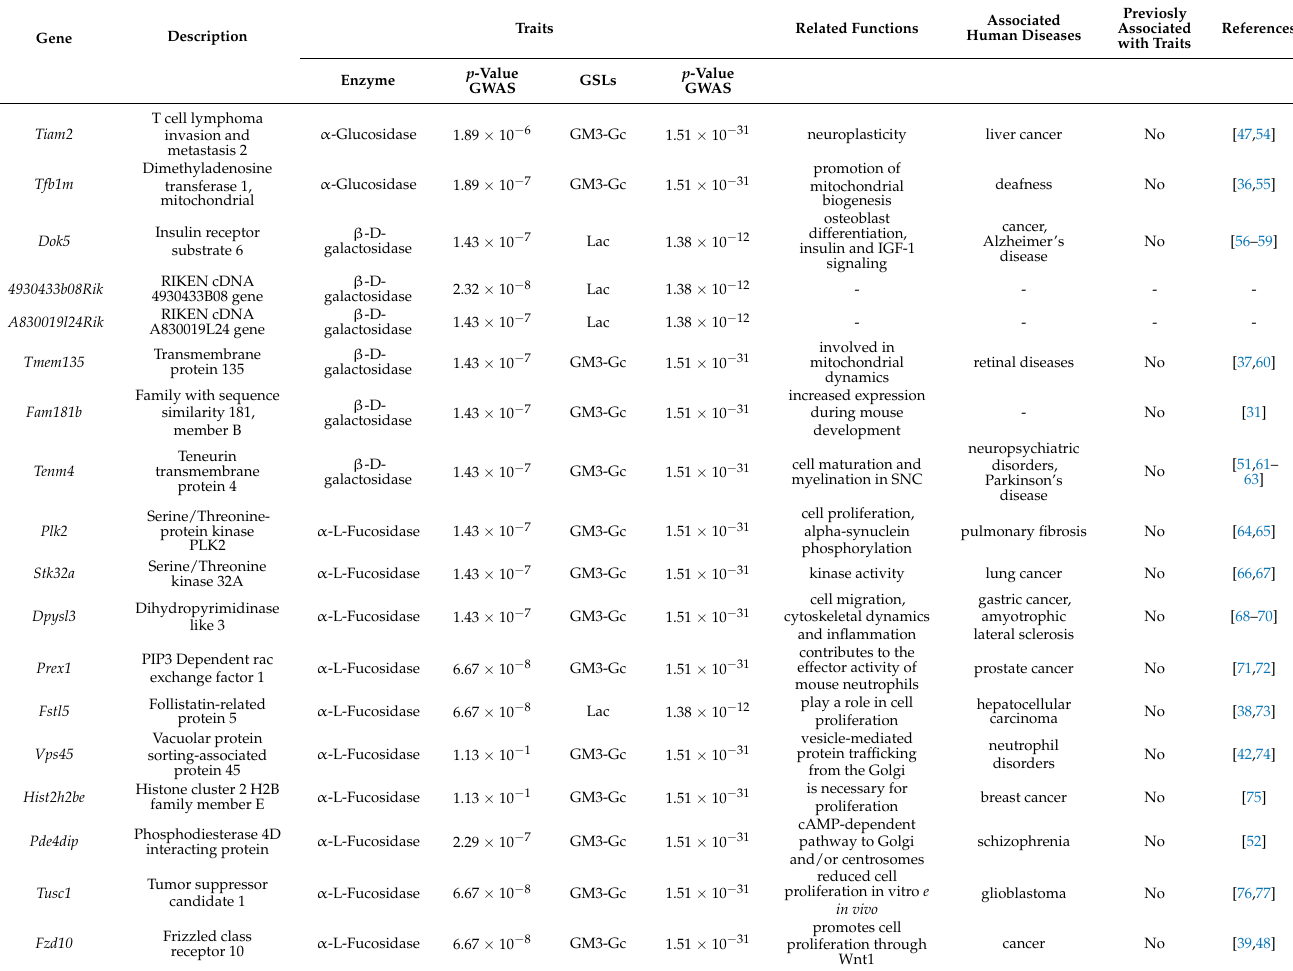
Table 2. Common genetic modifiers associated with enzyme activity and hepatic glycosphingolipid lev- els in inbred mouse strains. The references related to this table are presented as supplementary material. Traits RelatedFunctions Associated HumanDiseases